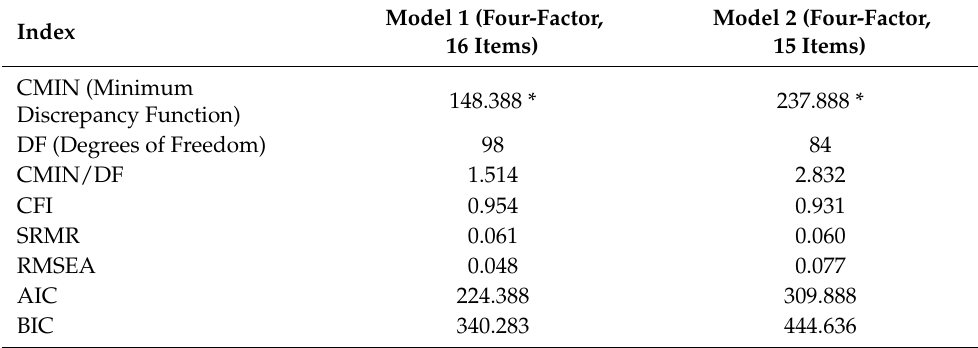
Table 5. Model Fit Indices for Model 1 and Model 2.